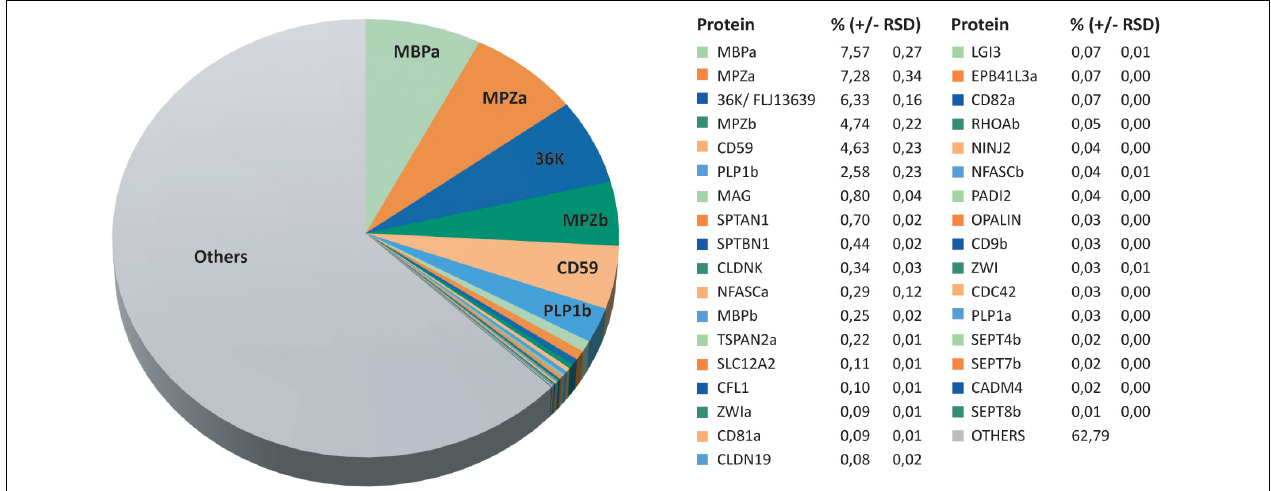
FIGURE 2 | Relative abundance of CNS myelin proteins in zebrafish. Pie chart visualizing the MS E dataset ( Figure 1C and Supplementary Table 1 ). The relative protein abundance is given in percent with relative standard deviation (RSD). Note that known myelin proteins constitute about 37% of the total myelin protein, whereas proteins so far not associated with myelin constitute the remaining